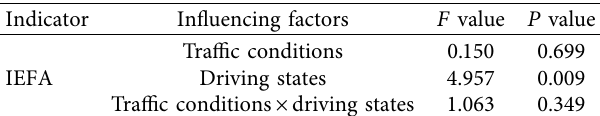
Table 4: Two-way ANOVA of IEFA.